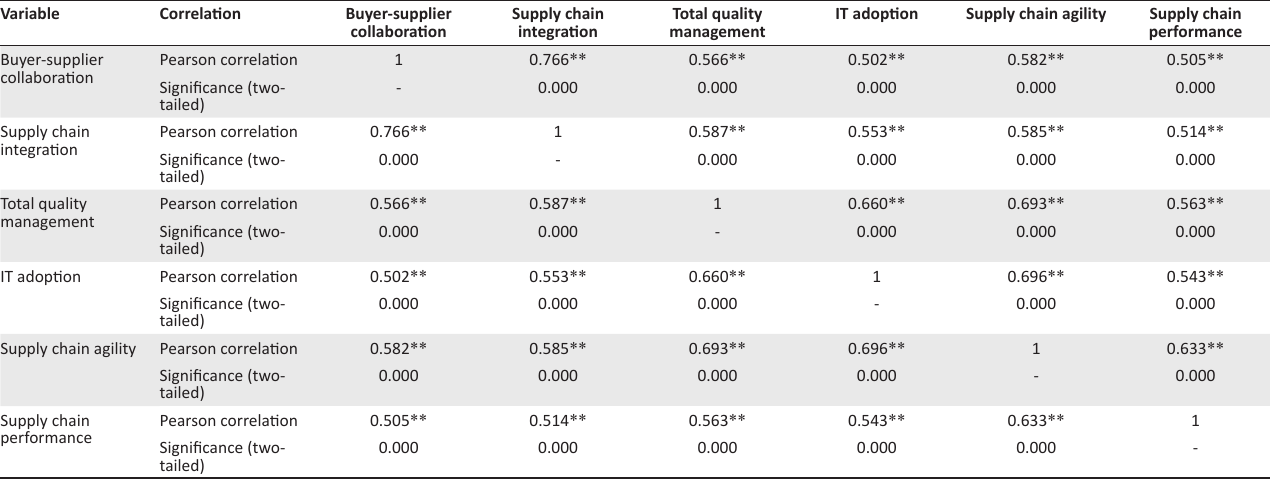
TABLE 3: Correlation analysis. Variable